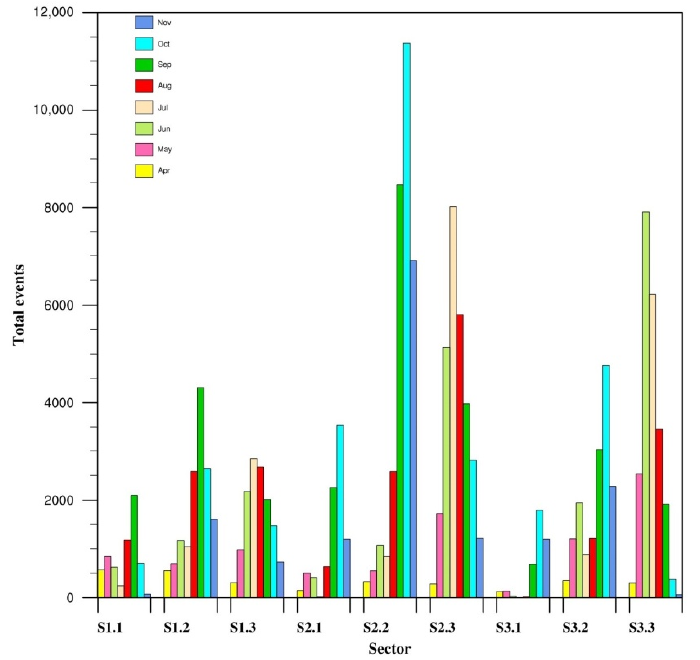
Figure 5. Total number of H events in the period April-November from 1999 to 2021 for each sector of Figure 1.